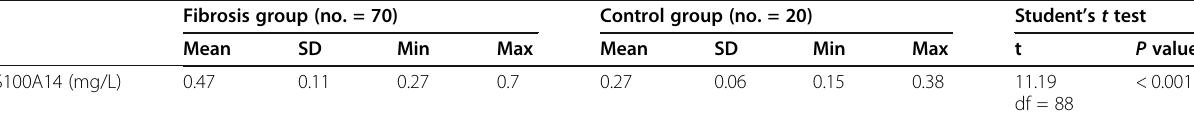
Table 2 S100A14 values in all studied groups Fibrosis group (no. = 70) Control group (no. =